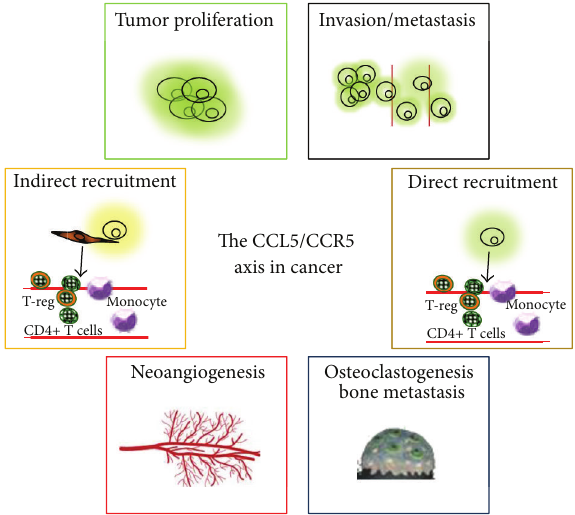
Figure 1: Effects of the CCL5/CCR5 interactions in cancer. Cancer cells secrete CCL5 or induce fibroblasts to secrete CCL5 which act in a paracrine or autocrine fashion on CCR5-positive tumor cells to sustain their proliferation, to recruit immunosuppressive cells (T-reg cells, monocyte), to induce osteoclasts activation and bone metastasis, to induce neoangiogenesis, and to guide tumor cells to disseminate to distant